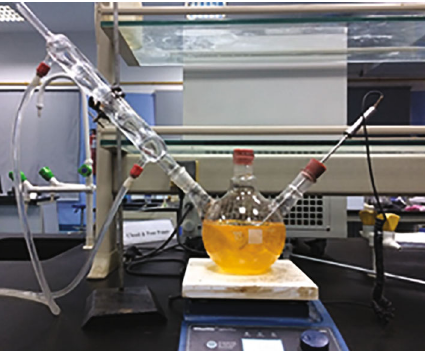
Figure 1: Experimental